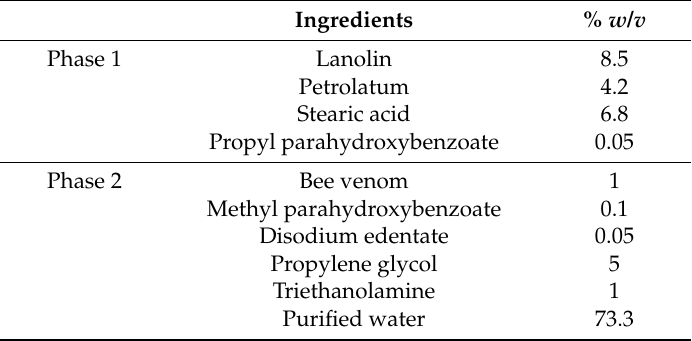
Table 3. Composition of emulsion containing 1% bee